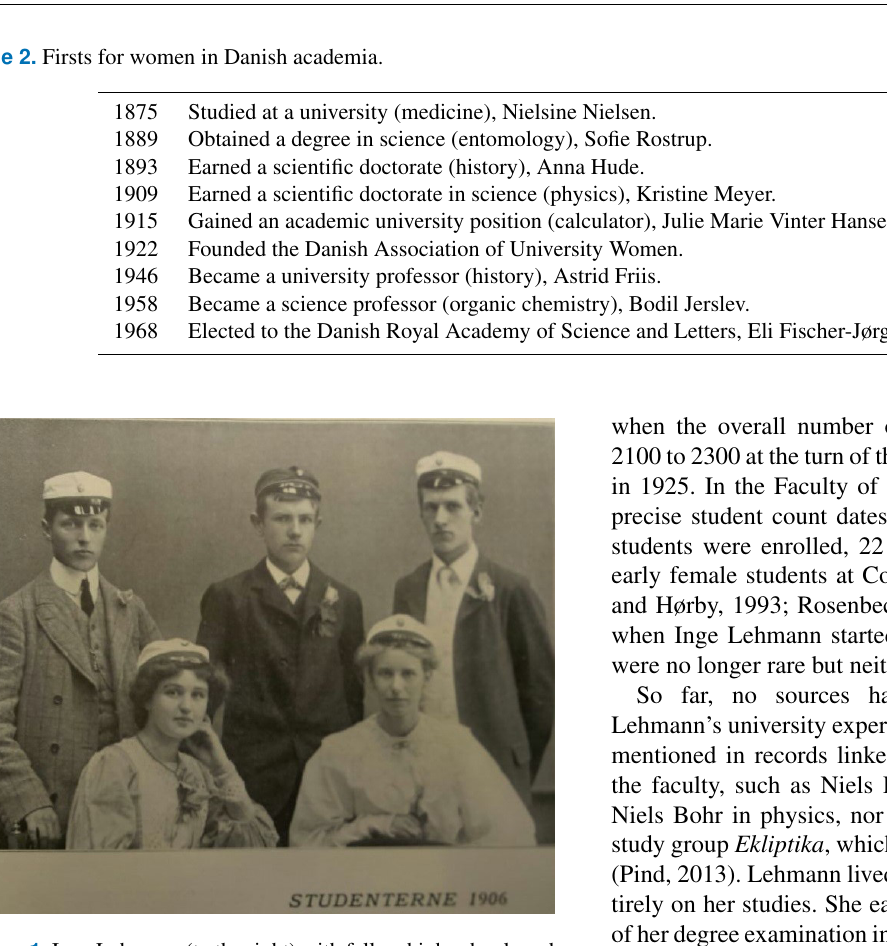
Figure 1. Inge Lehmann (to the right) with fellow high school grad- uates, 1906 – the first year women graduated on equal terms with men (unknown photographer, 1918, Frk. H. Adler’s Fællesskole 1893–1918.